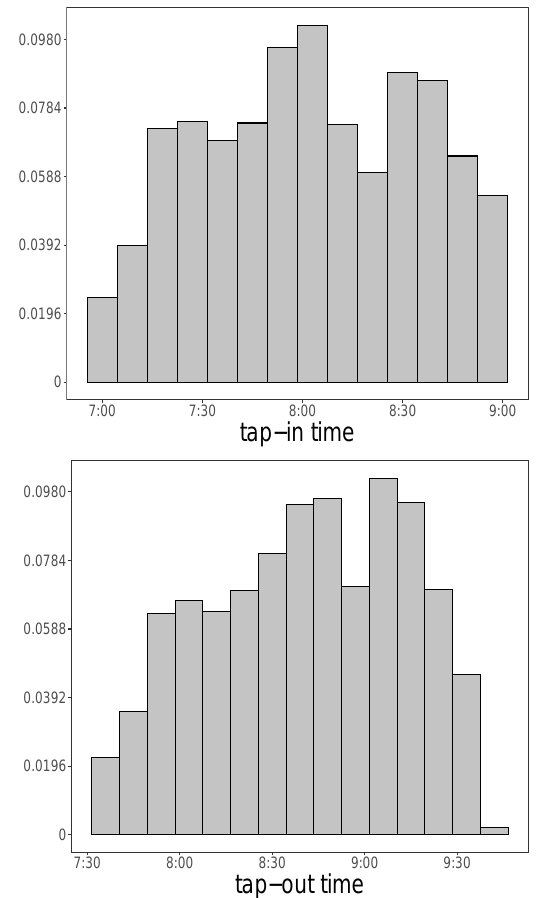
Figure 4. Frequency histograms of tap-in and tap-out times of Route A passengers in peak hours. According to the data, the departure interval between two trains at Wuzixueyuanlu is about 3 min. The train travel times of segments 1 and 2 are about 21 and 6 min, respectively.